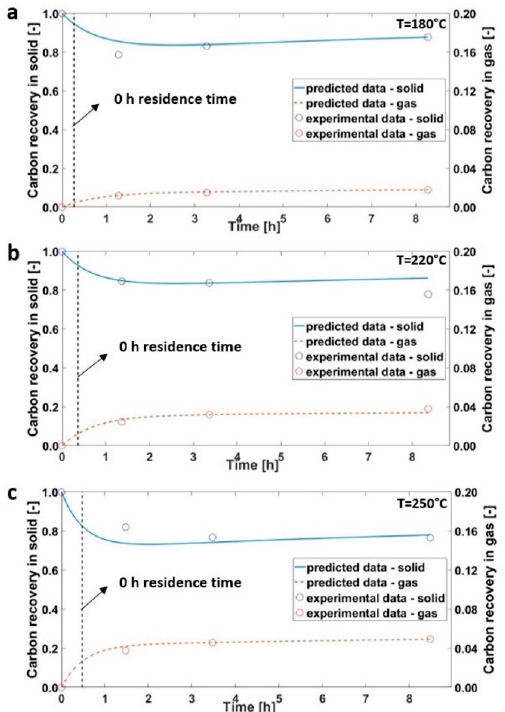
Figure A1. Carbon recovery in solid and gas phases for grape marc: ( a ) 180 °C, ( b ) 220 °C, and ( c ) 250 °C.